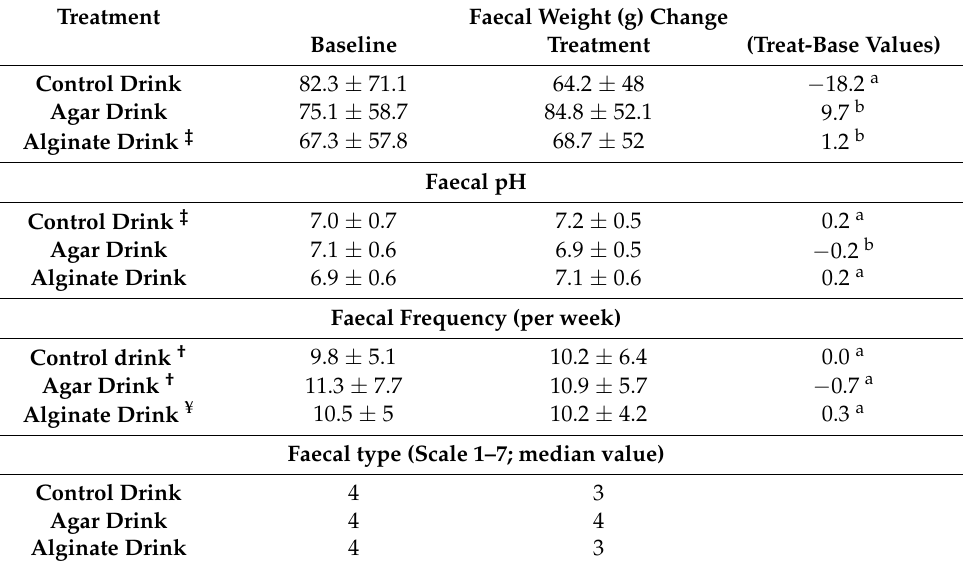
Table 3. Faecal characteristics resulting from consumption of control, agar, and alginate drink(s).